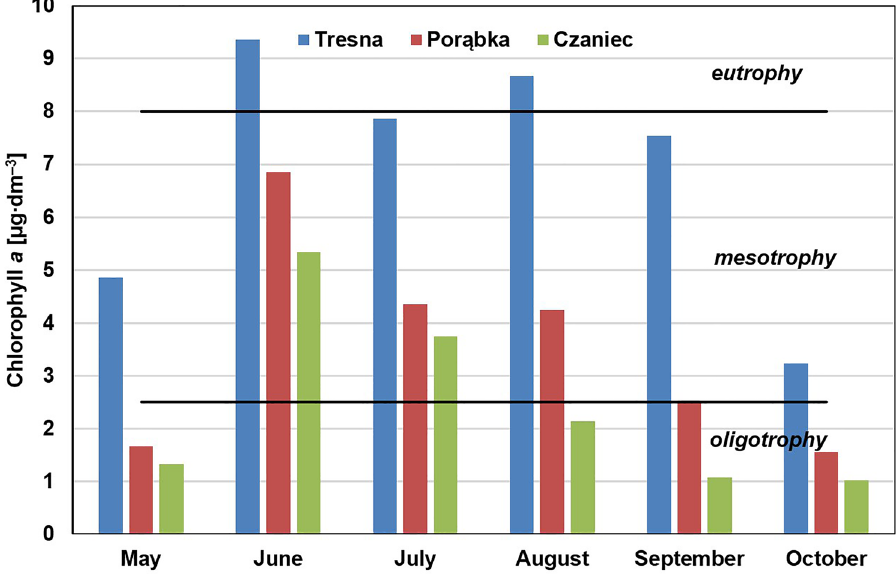
Figure 3. Concentrations of chlorophyll a in water of the Soła cascade reservoirs in 2019 year and the OECD trophic classification 11 .